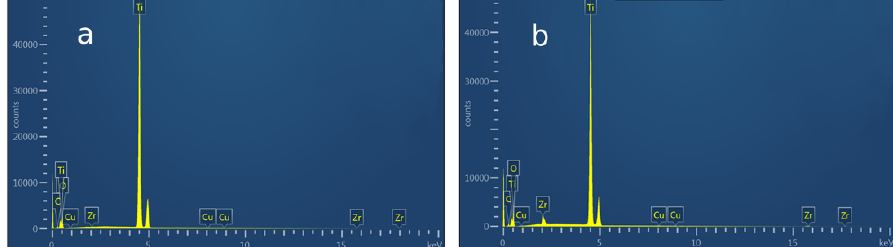
Figure 4. Qualitative EDX spectra of ( a ) unmodified TiO 2 and ( b ) P25/Zr (1%)/Cu (0.05).